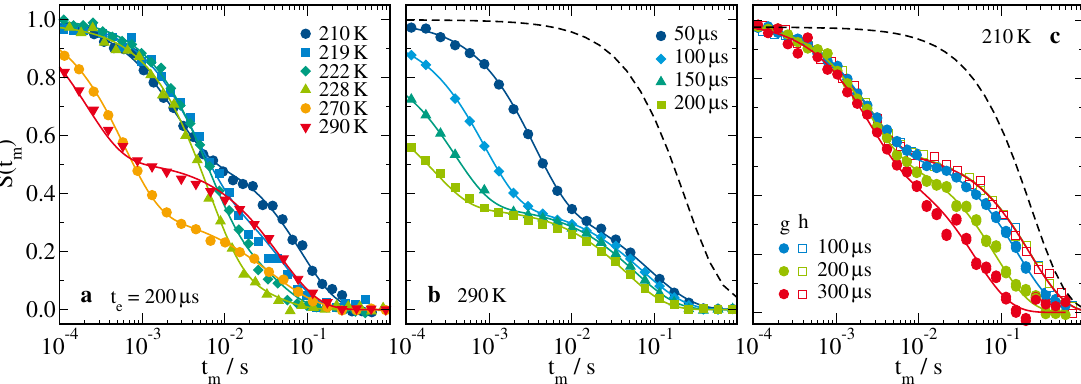
Figure 10. 1 H SFG STE decays of 66mol% H 2 O-DMSO- d 6 in ficoll confinement at the solvent fraction w s = 70wt%: ( a ) S ( t m ) for t e = 200 µ s at the indicated temperatures together with S ( t m ) for various evolution times t e at ( b ) 290K and ( c ) 210K. In the latter panel, we compare results from identical measurements in gradient (g) and homogeneous (h) magnetic fields. The solid lines are fits to a superposition of the respective free-diffusion decays of two components at higher temperatures, see Equation (10), and to the free-diffusion decay of a faster component in the presence of cross relaxation to a slower component below 230K, see Equation (12).